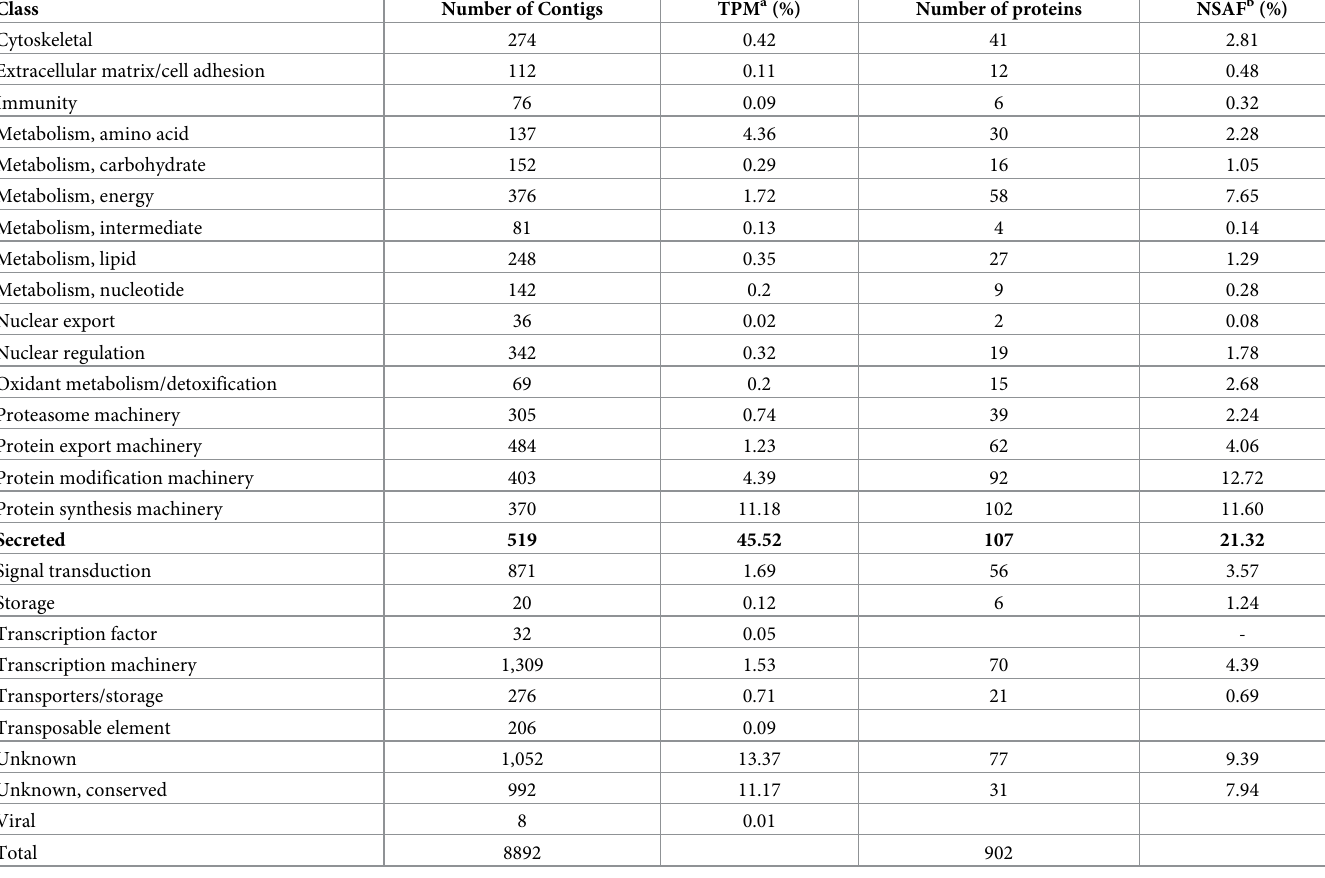
Table 1. Functional classification and quantification of transcripts and proteins identified in C . felis salivary gland